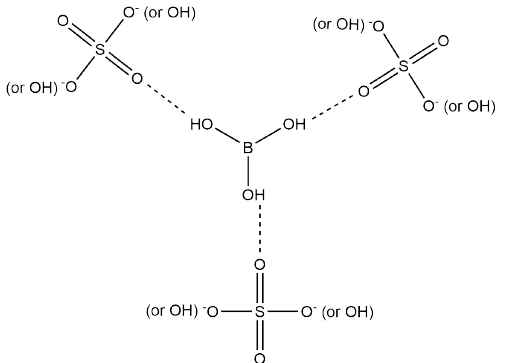
Figure 8. Suggested interaction of boric acid with sulfate, hydrogen sulfate ions and/or sulfuric acid